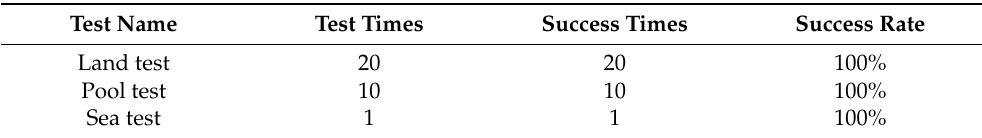
Table 4. Table 4. The results of